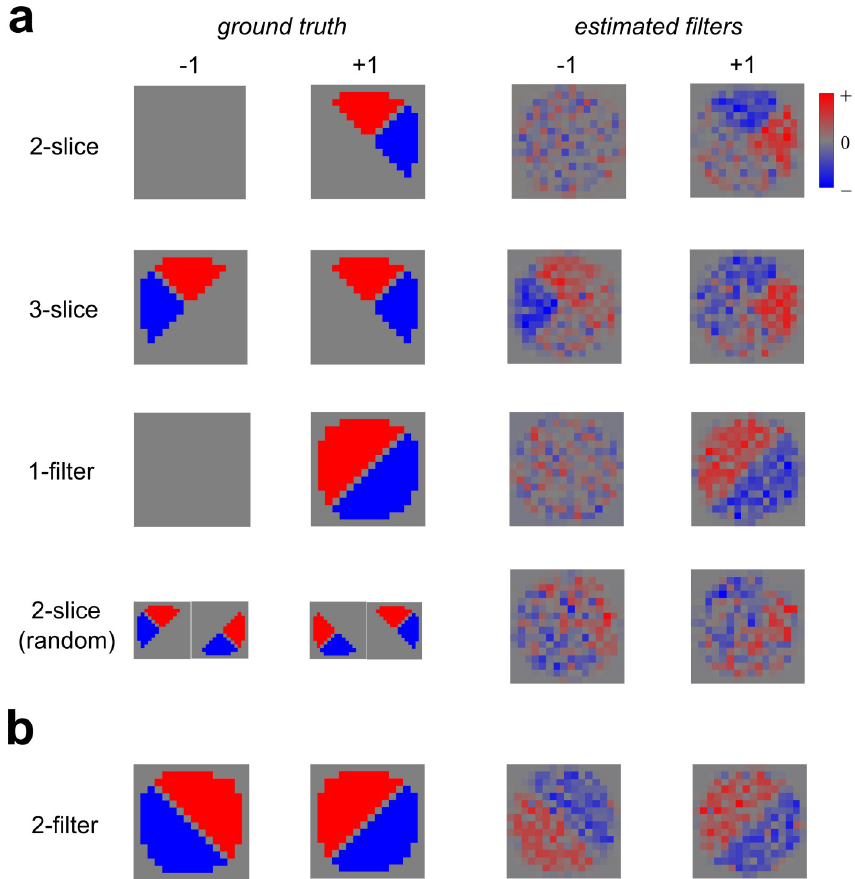
Fig 10. Simulated ground-truth observers (left columns) and filter shapes recovered (right columns) from simulated datasets generated by these observers. (a) Ideal observers implementing various sub-optimal spatial filtering models for Experiment 1. Top row : Simulated observer monitors two adjacent “pizza slice” shaped regions (2-slice). Second row : Simulated observer monitors three adjacent regions (3-slice). Third row : Simulated observer only monitors one boundary (1-filter). Bottom row : Simulated observer randomly monitors 1 of 4 pairs of informative adjacent pizza slices (2-slice—random). (b) Ideal observer implementing a spatial filtering model comprised of two perceptual filters, each monitoring one potential boundary (2-filter). The recovered filters (right) are most similar to those observed in our results (Fig 3).